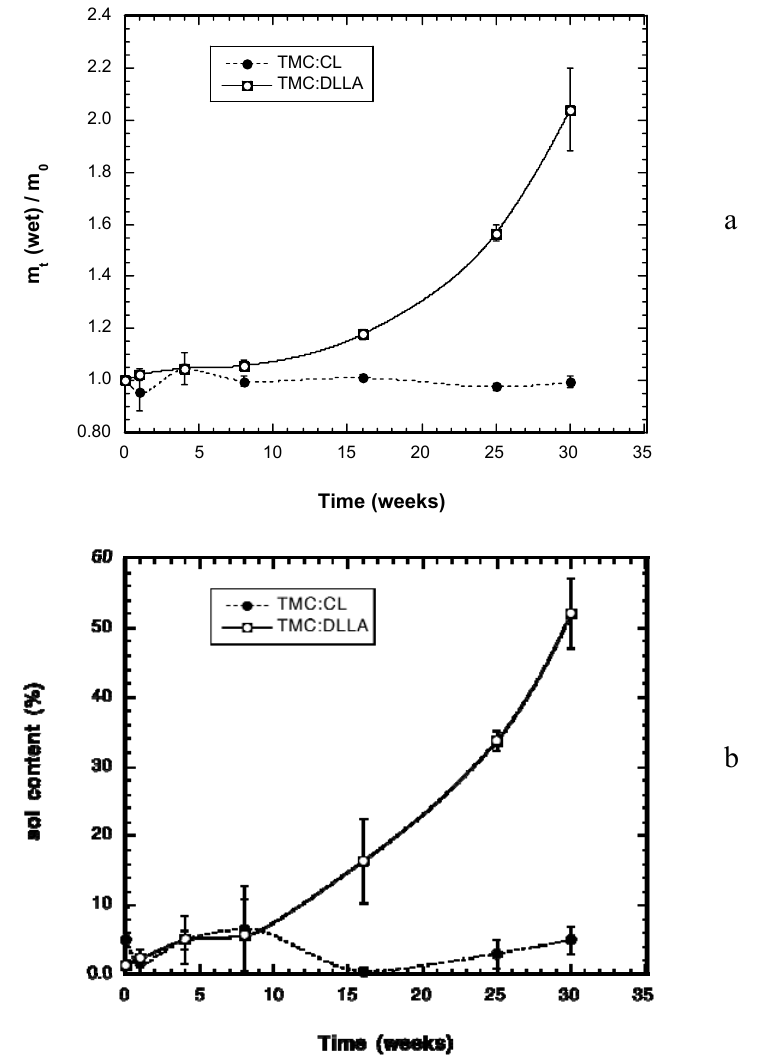
Figure 3. (a) Change in wet weight of the implanted TMC-DLLA and TMC:CL cylinders with time. The data is presented as the ratio of the wet (immediately after explantation) ) to the initial dry weight (m ). (b) Change in elastomer sol contents with time weight (m t 0 during implantation.